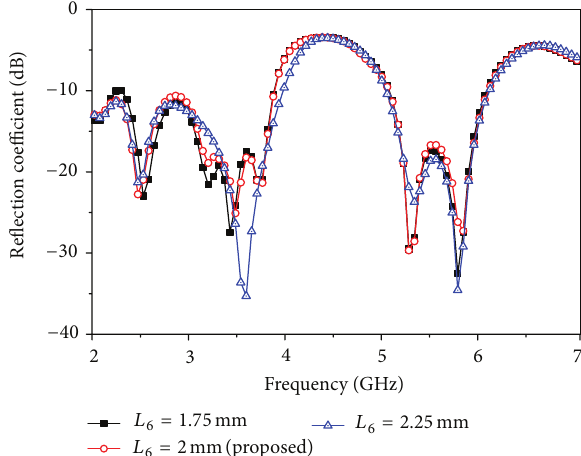
Figure 3: Effect of reflection coefficient for the different length of patch slot 𝐿 4 .